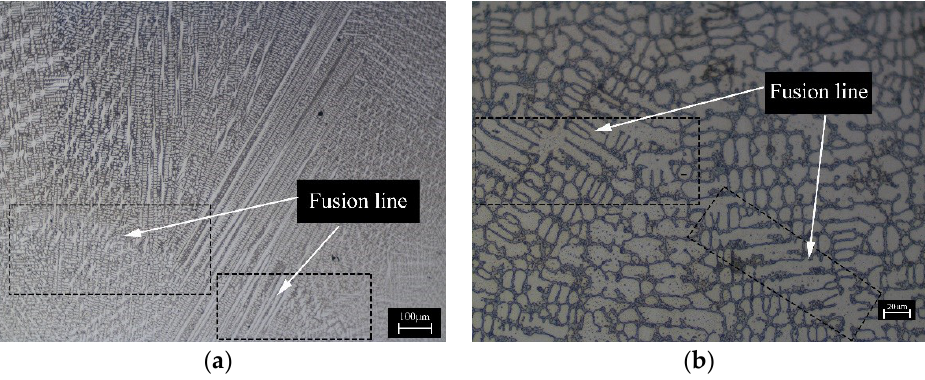
Figure 7. The detail of fusion line at 100× magnification ( a ) and at 400× magnification ( b ).